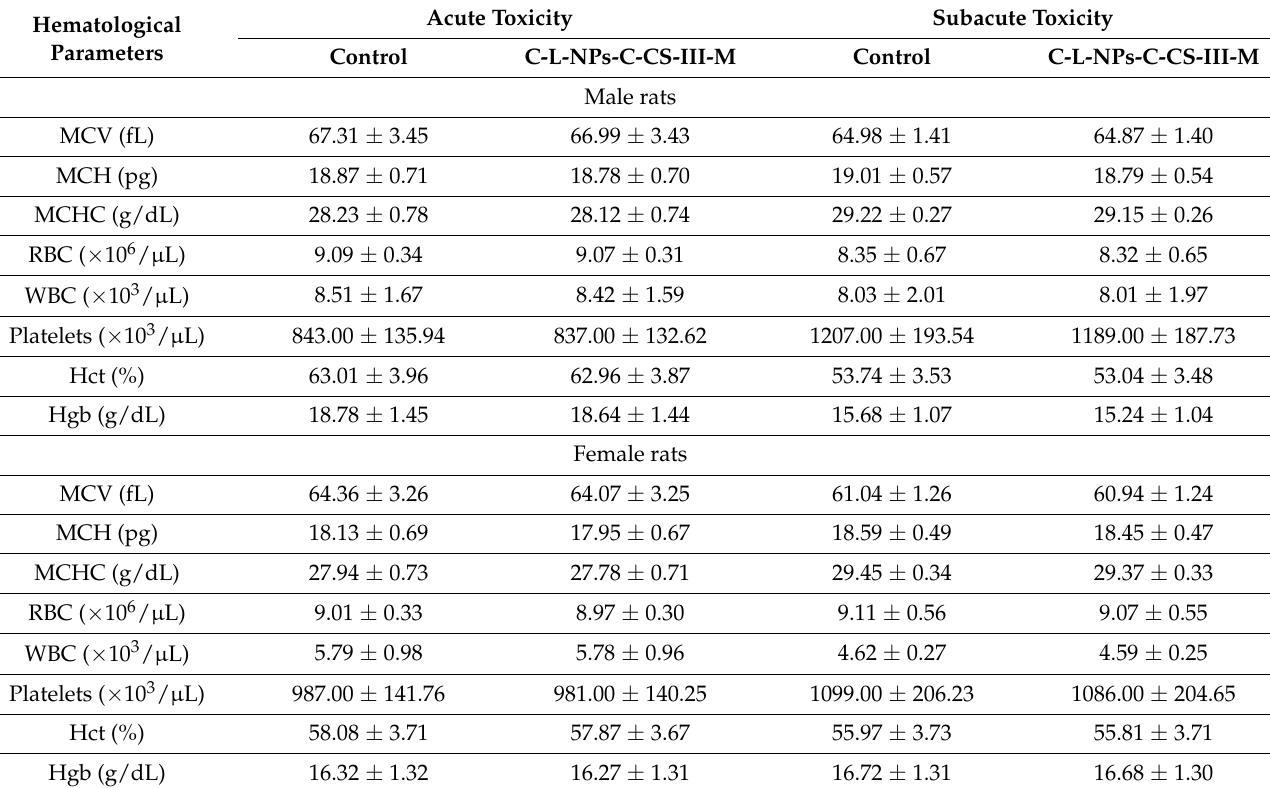
Table 12. Hematological parameters of rats following oral administration of C-L-NPs-C-CS-III-M . Hematological